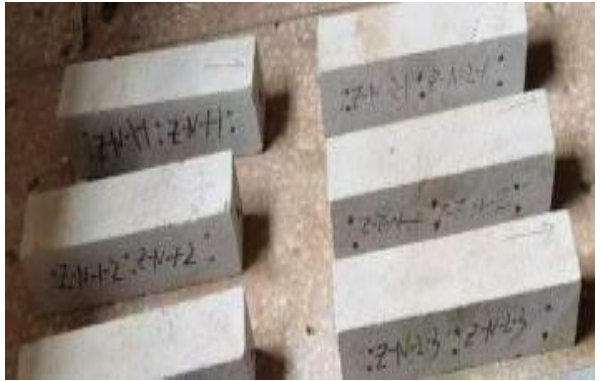
Figure 1. Autoclaved aerated concrete wallboard specimens.